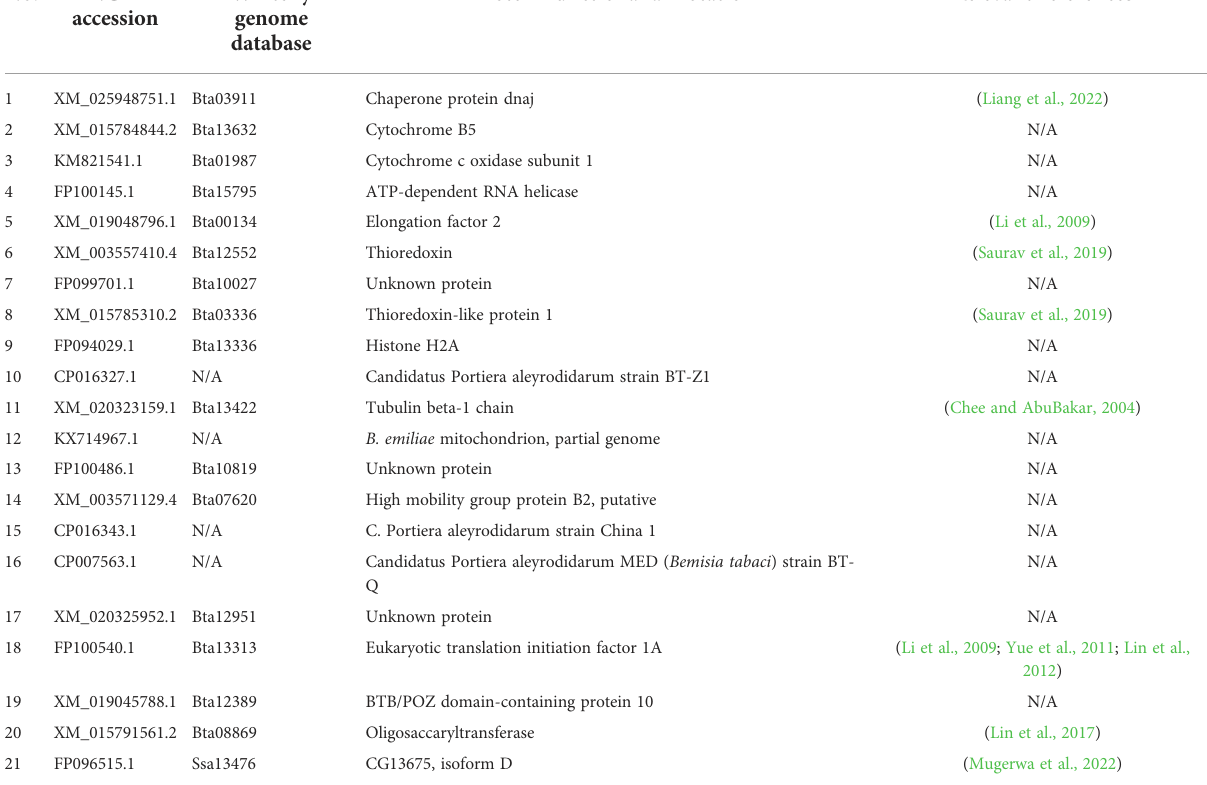
TABLE 1 List of putative white fl y proteins interacting with CLCuMuV- AV1 in Y2H assay. No.